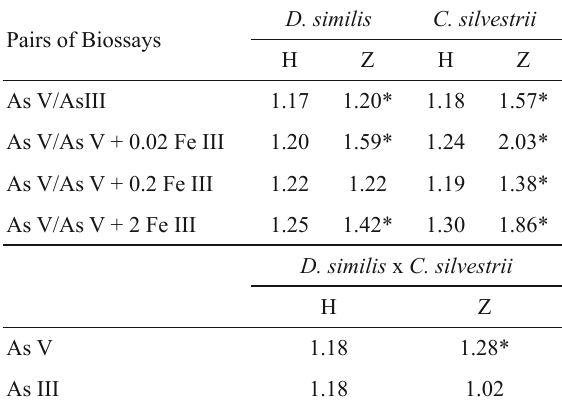
Parameters H and Z obtained from EC50 – 48 h mean values for As III and As V and As V associated with Fe for D. similis and C. silvestrii .